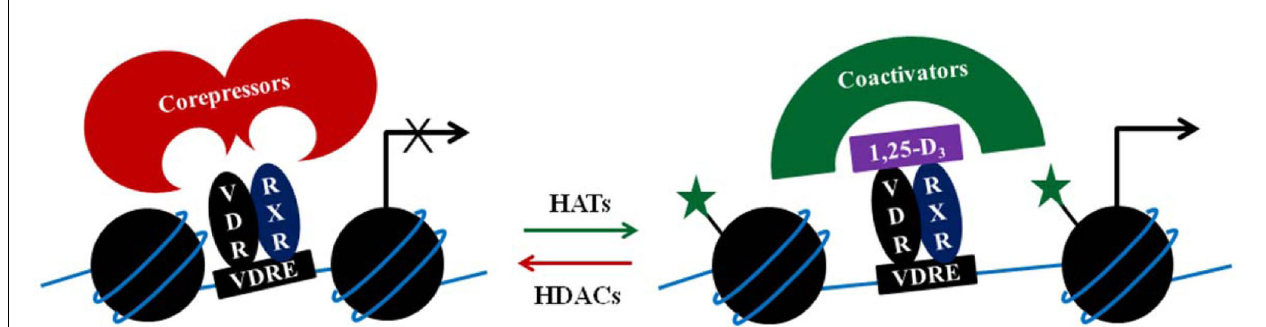
FIGURE 1 | Simplified illustration of a two-step coregulator model. The VDR/RXR complex in absence of the 1,25-D 3 may bind corepressors that would lead/maintain gene repression, partly by attracting histone deacetylases (HDACs). Upon ligand binding to the